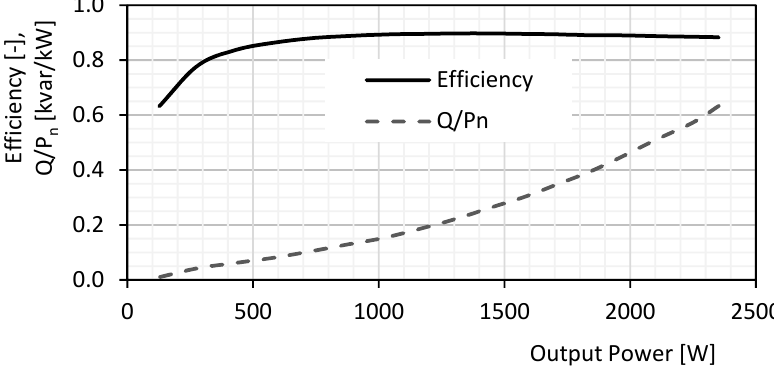
Table 2. Results of the investigated generator at 1500 rpm and 56 ohm load. Figure 9. E ffi ciency and reactive power ratio measurements at 1500 rpm. Figure 9. Efficiency and reactive power ratio measurements at 1500 rpm.